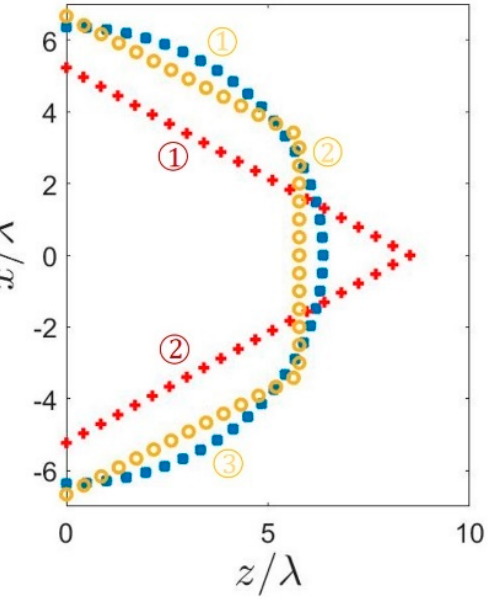
Figure 4. A semi-circumference array (blue stars), a trapezoidal array made of three linear arrays (yellow circles), and an angle array (red crosses) with the same number of elements. All the supports have the same length L = 20 λ .